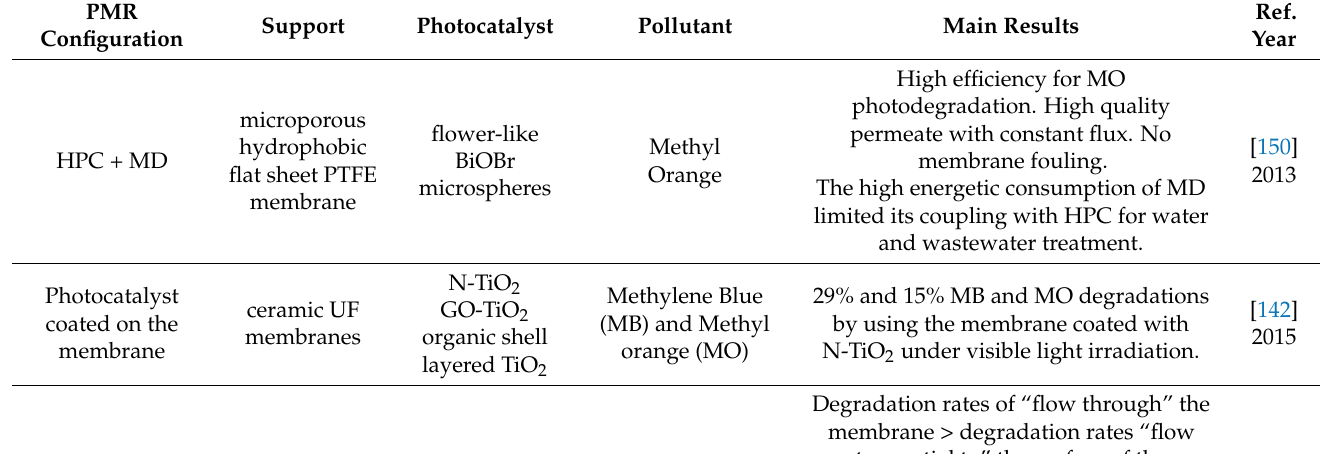
Table 3. Summary of various PMR configurations working under visible light in water treatment and their main